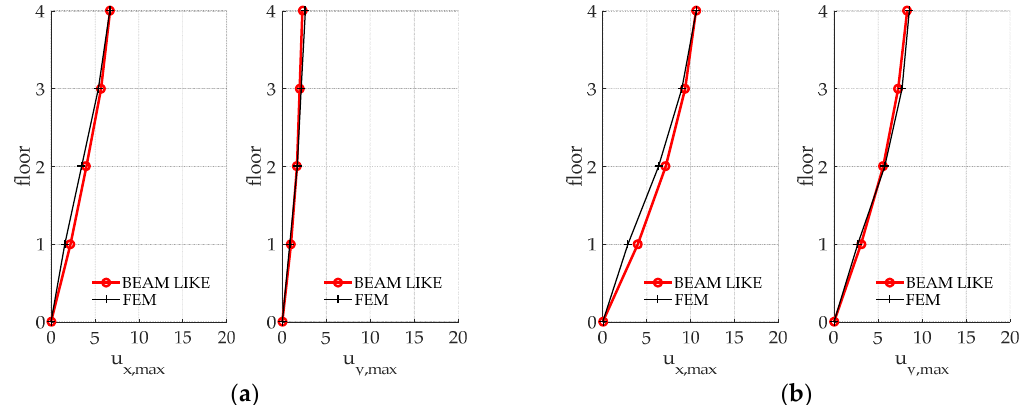
Figure 9. Four-storey benchmark. L’Aquila earthquake. Displacements time history along the ( a ) x and ( b ) y direction.